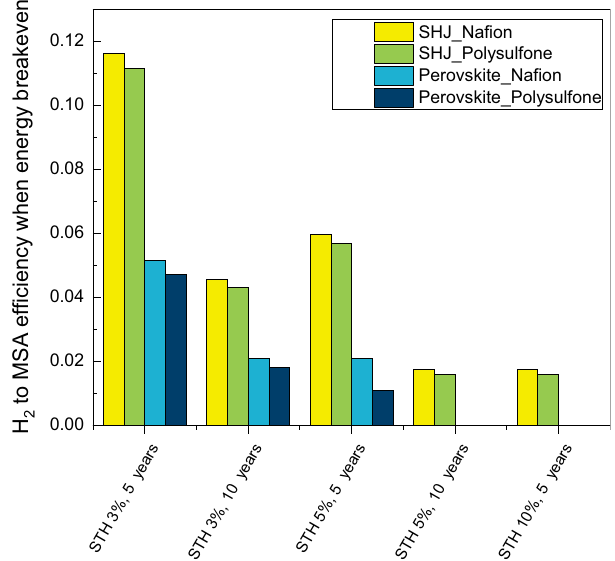
Fig. 4 | Energetic impact of substituting components of the coupled PEC device. ThresholdH 2 -to-MSAconversionef fi ciencyforenergytobreakeveninfour cases of using different bottom absorber and membrane combinations in our coupled PEC device. No conversion ef fi ciency is shown for case 3 (Per- ovskite_Na fi on) and case 4 (Perovskite_Polysufone) when the STH is 10% and the longevity is 5 years since H 2 production itself is suf fi cient to pay back the energy investment, i.e., no H 2 -to-MSA conversion is